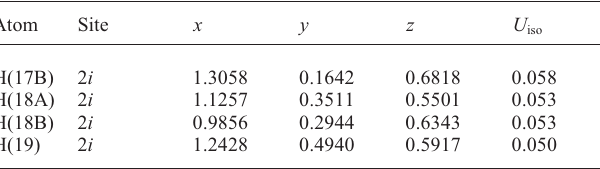
Table 3. Atomic coordinates and displacement parameters (in Å 2 )